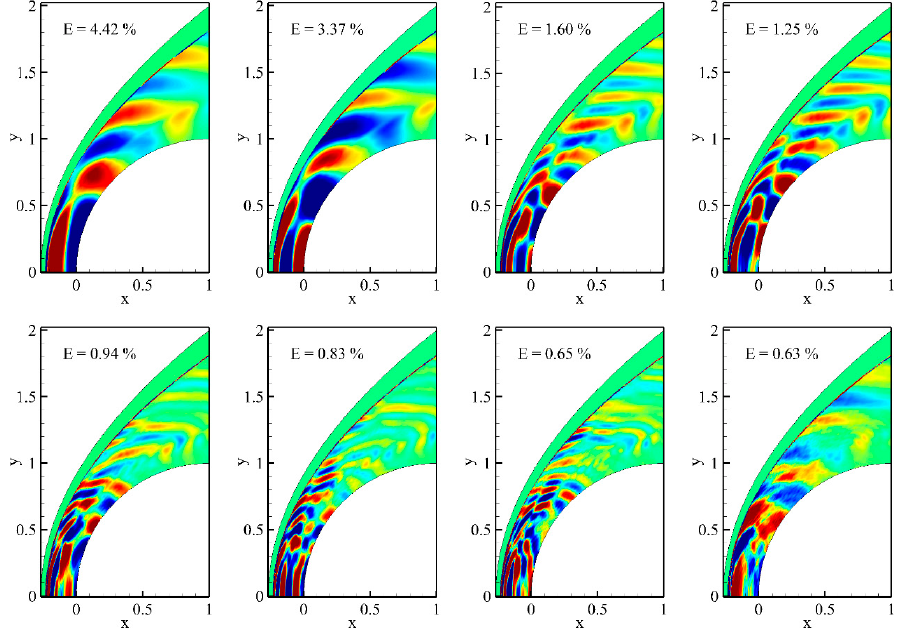
Figure 21. Spatial coherent structure of the flow field with POD analysis for with UCSD reaction mechanism for 400 × 600 grid resolution (E represents normalized eigen value.). POD color scale is the same as Figure 19.